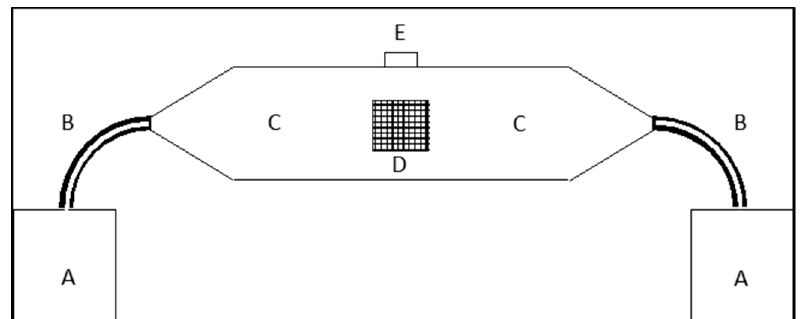
Figure 2. Schematic representation of the two-choice cage used for oviposition deterrence assays. A, 700 mL glass chamber; B, PVC connection tube; C, central chamber; D, net-covered holes for air supply; E, insect entrance (with cap).